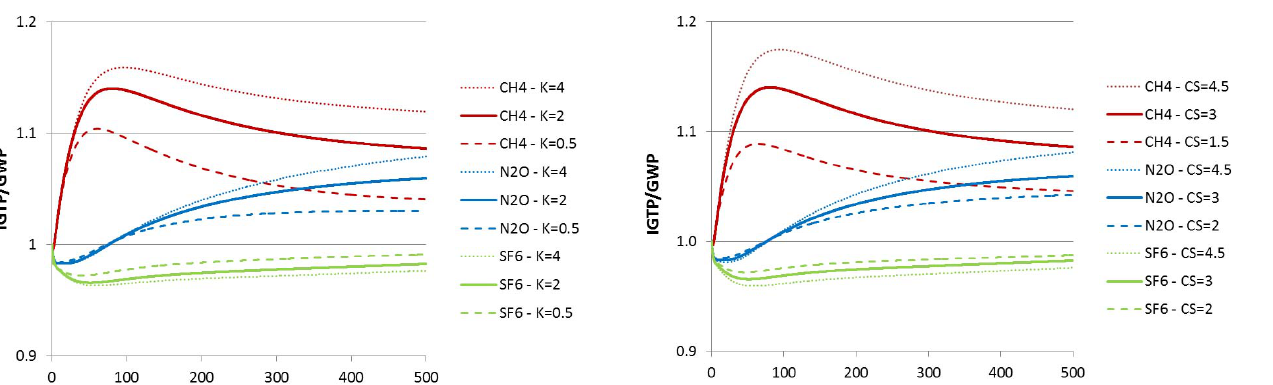
Fig. 3. IGTP/GWP ratio for CH 4 , N 2 O and SF 6 depending on cli- mate sensitivity. CS, the climate sensitivity, is given in Kelvins per CO 2 equivalent